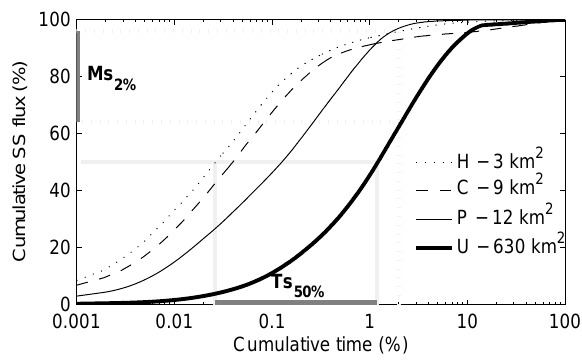
Fig. 3. Suspended sediment flux duration curves at the four sta- tions. Grey lines correspond to the range of the Ms 2% and Ts 50%